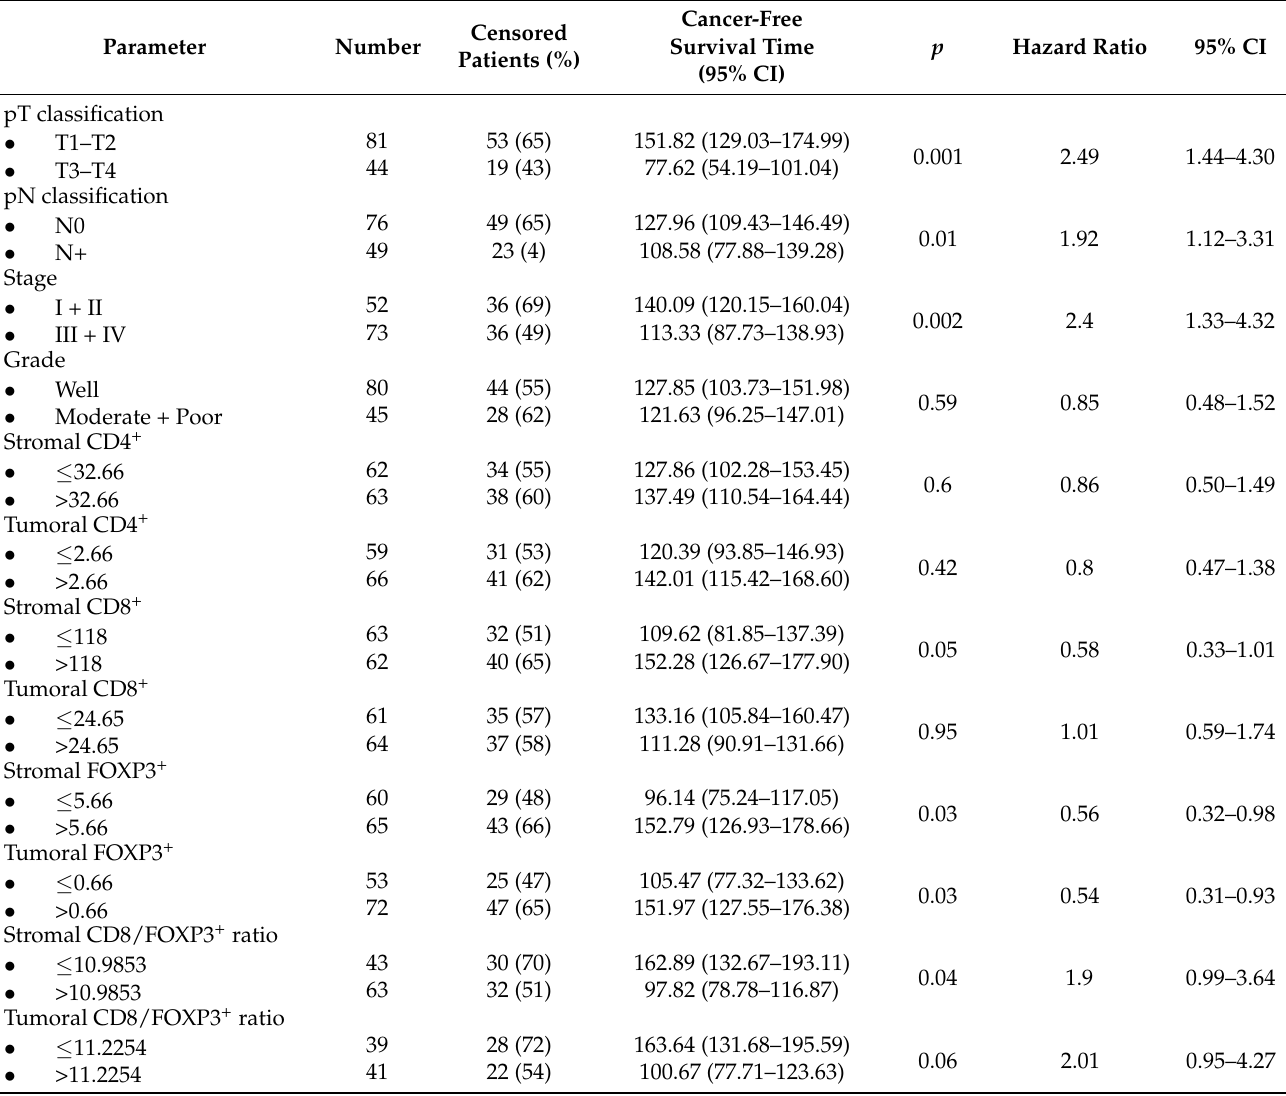
Table 4. Kaplan-Meier and univariate Cox cancer-free survival analysis in the cohort of 125 patients with OSCC.